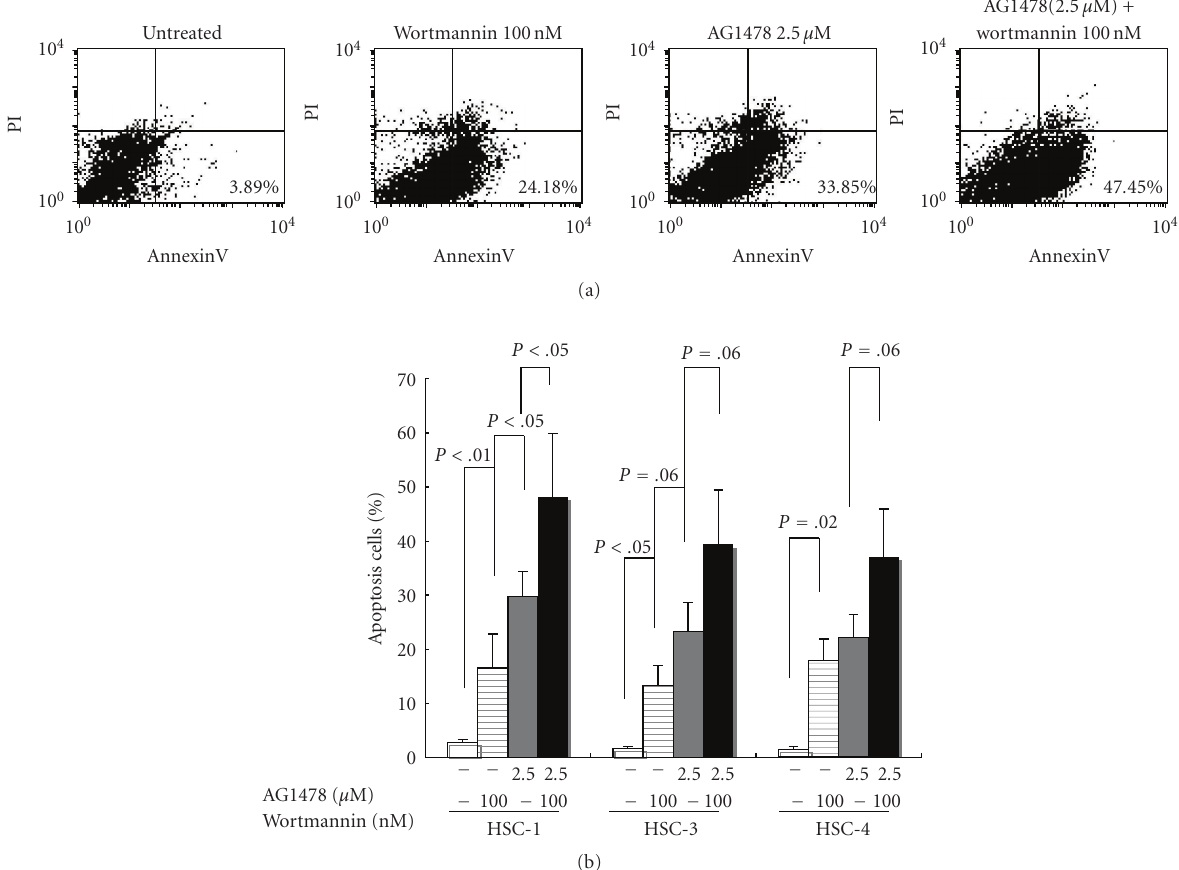
Figure 6: Analysis of apoptosis induced by AG1478 and wortmannin in HSC-1 cells. HSC-1 cells were incubated with AG1478 and/or wortmannin at the indicated concentration for 24 hours. Cells were incubated with Annexin V-FITC in a bu ff er containing propidium iodide (PI) and analyzed by flow cytometry (a). Data are representative of at least four independent experiments. Annexin V-FITC positive and PI negative cells are apoptotic (lower right quadrant) (a). Annexin V-FITC positive and PI positive cells are necrosis (upper right quadrant) (a). HSC-1, 3, and 4 cells were incubated with AG1478 (2.5 μ M) and/or wortmannin (100 nM) for 24 hours. Cells were incubated with Annexin V-FITC in a bu ff er containing propidium iodide (PI) and analyzed by flow cytometry. Results are means ± SD of at least three independent experiments (b). Statistical significance of the di ff erence between each group was determined using Student’s t -test and analysis of